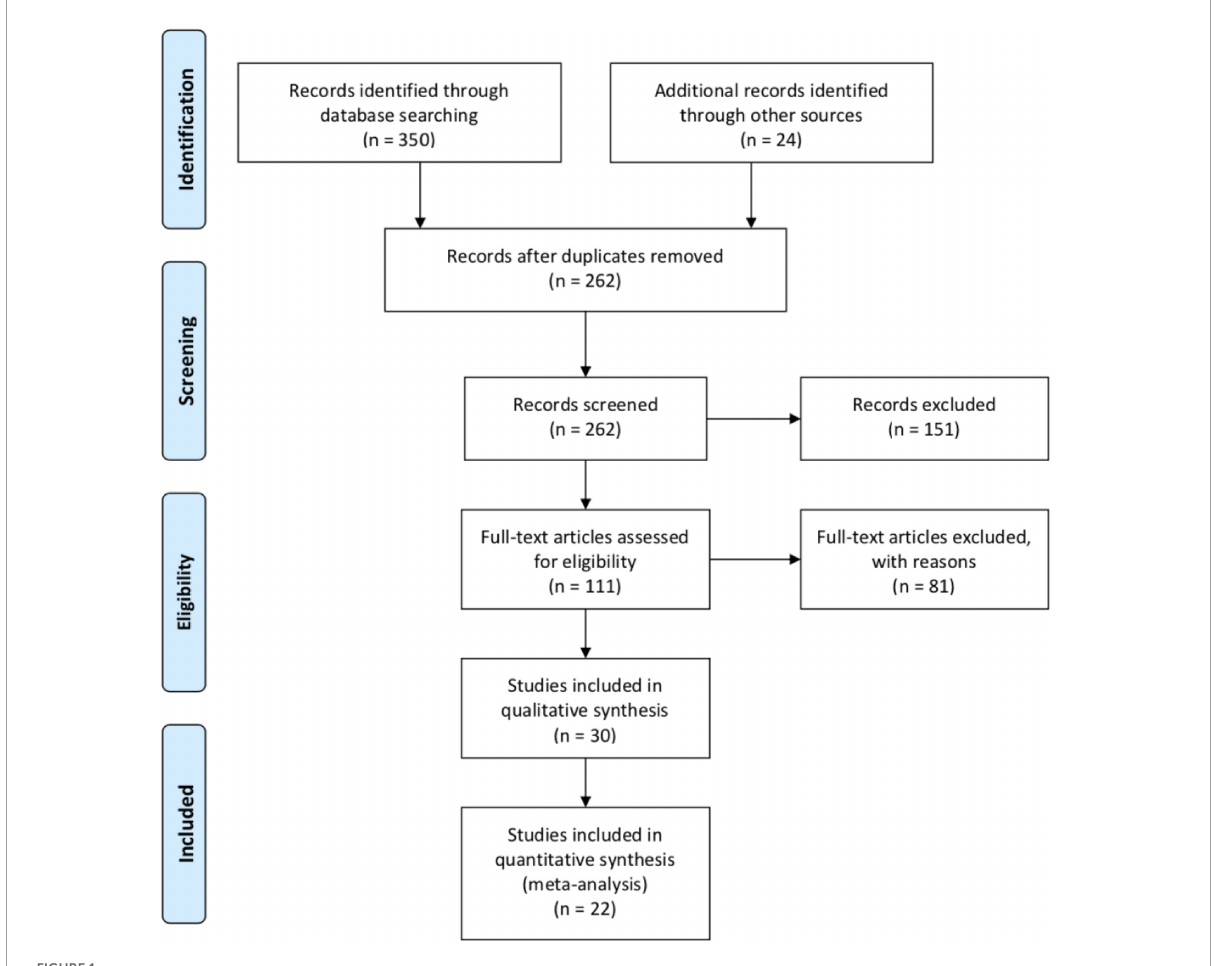
FIGURE1 Flow chart of searching